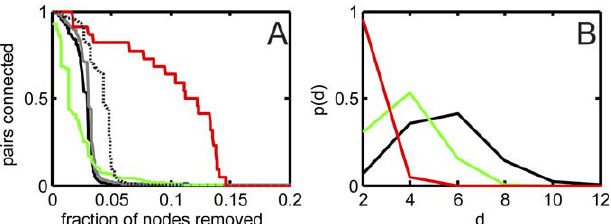
Figure 8. Modularity Analysis and Distance Distribution for Topological Clustering (A) Fraction of pairs of genes that remain connected upon removal of nodes with the highest betweenness centrality, for the evolved network depicted in Figure 5. Red line, synthetic lethal pairs; green, knockdown rescue pairs; black solid line, random pairs; black dotted line, random pairs of a random network; grey line, relative size of largest connected component. (B) Distance distribution of pairs of genes. Colors as in (A).